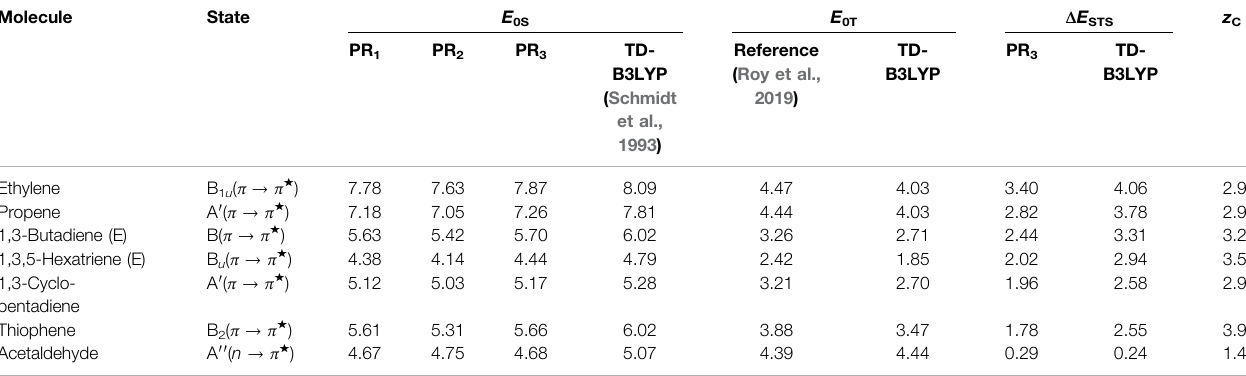
TABLE 12 | E 0 S , E 0 T , and Δ E STS (in eV) using B3LYP functional. For details, see Ghosal et al.